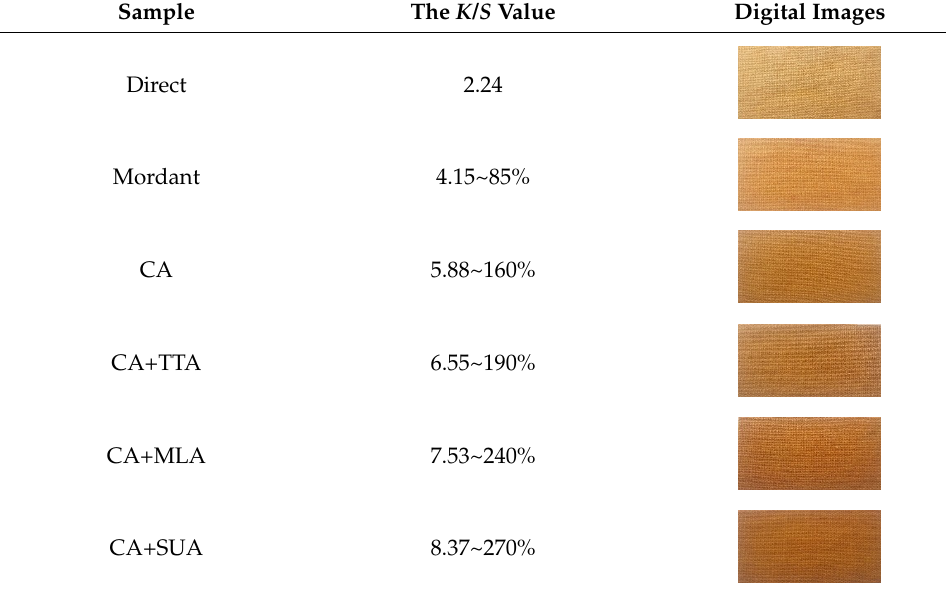
Figure 2. FTIR spectra of the cotton fabrics: a, Raw; b, Direct; c, Mordant; d, CA; e, CA+TTA; f, CA+MLA; g, CA+SUA. Table 1. The K/S values and digital images of the dyed cotton fabrics. Sample The K/S Value Digital Images Direct 2.24